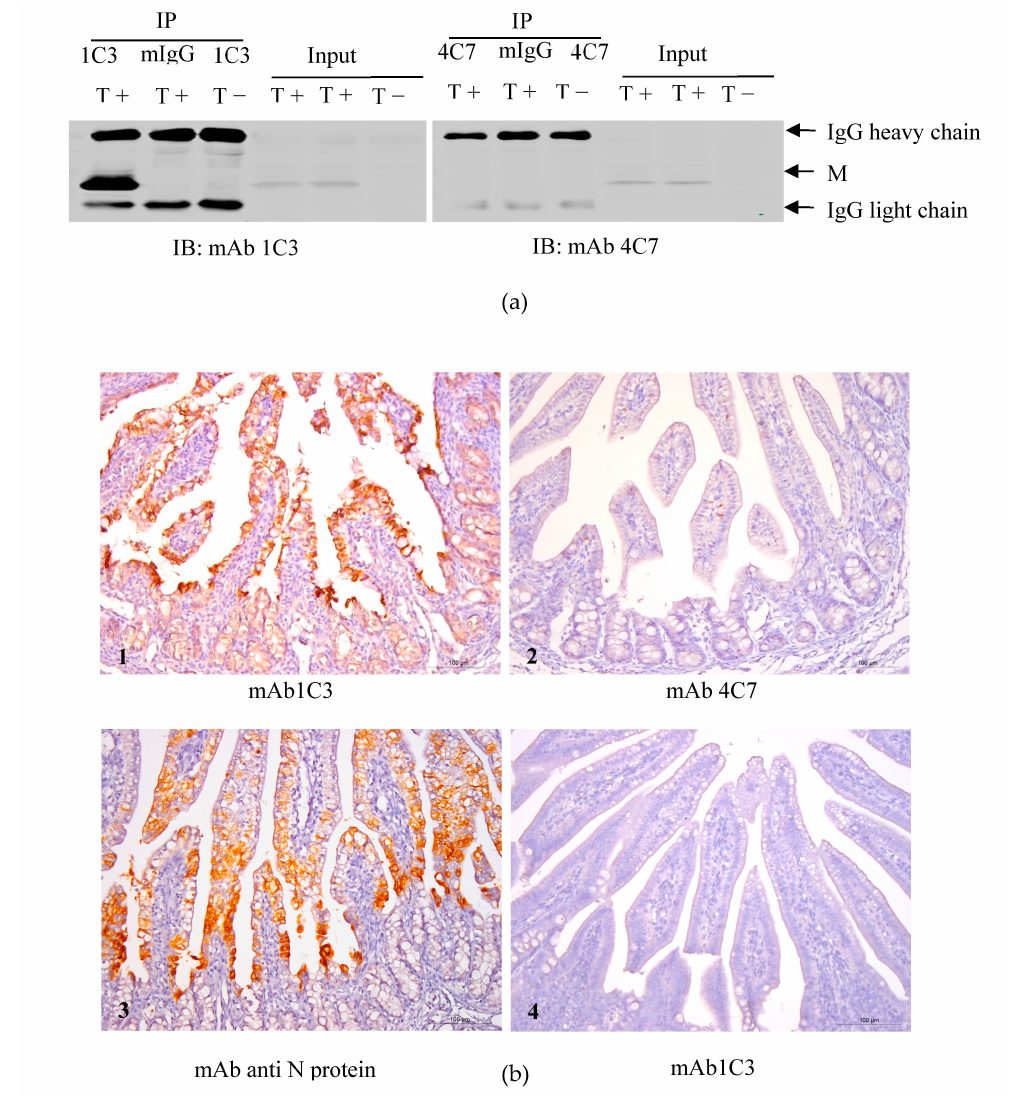
Figure 5. Application of the generated mAbs 1C3 and 4C7 in IP and immunohistochemistry (IHC). ( a ) Immunoprecipitation analysis of the M protein in TGEV-infected PK-15 cells using 1C3 and 4C7 mAbs. T+ represents the cell lysates of TGEV-infected PK-15 cells. T − represents the cell lysates of mock-infected PK-15 cells. The mIgG represents mouse control IgG; ( b ) IHC analysis of the M protein in the small intestines of TGEV-inoculated animals using 1C3 (1) and 4C7 (2) mAbs and an N-protein mAb (3) as a positive control. Staining of the small intestines of mock-inoculated animals with 1C3 mAb is shown as a negative control